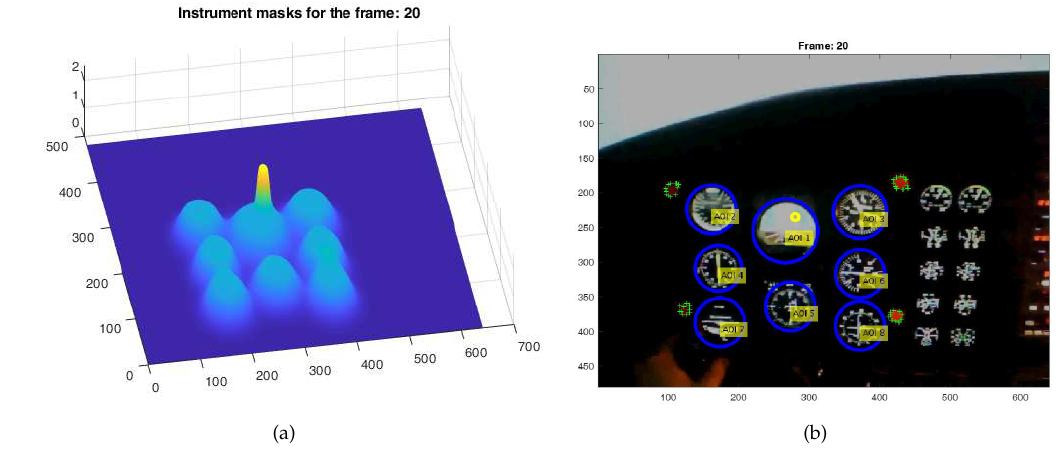
Figure 15. Instrument masks’ outlines position ( a ) and observers’ attention for Frame 20 ( b